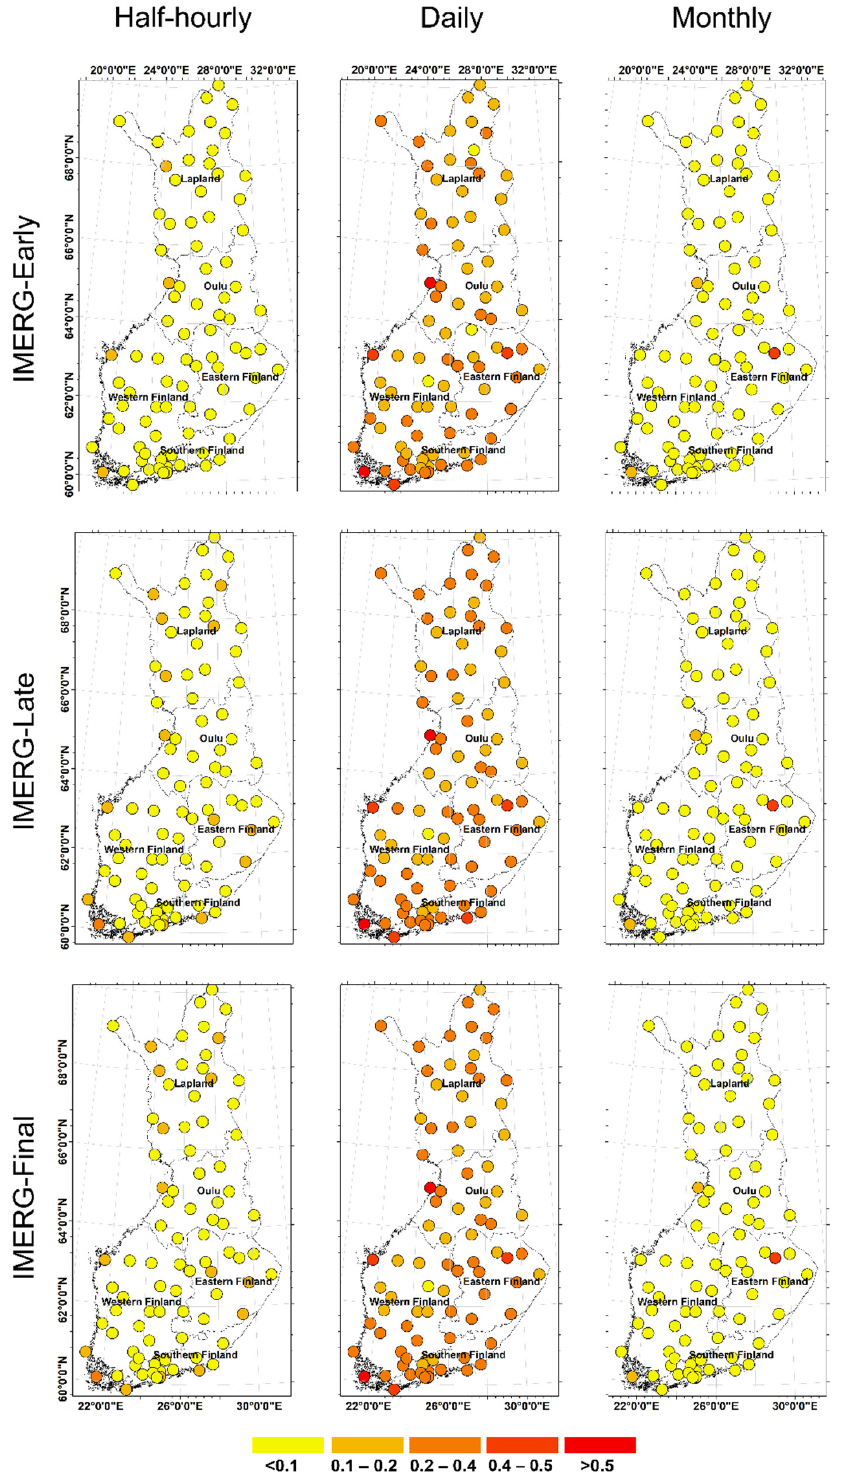
Figure 12. Spatial distributions of the hourly, daily, and monthly FAR for IMERG-Early, IMERG-Late, and IMERG-Final.